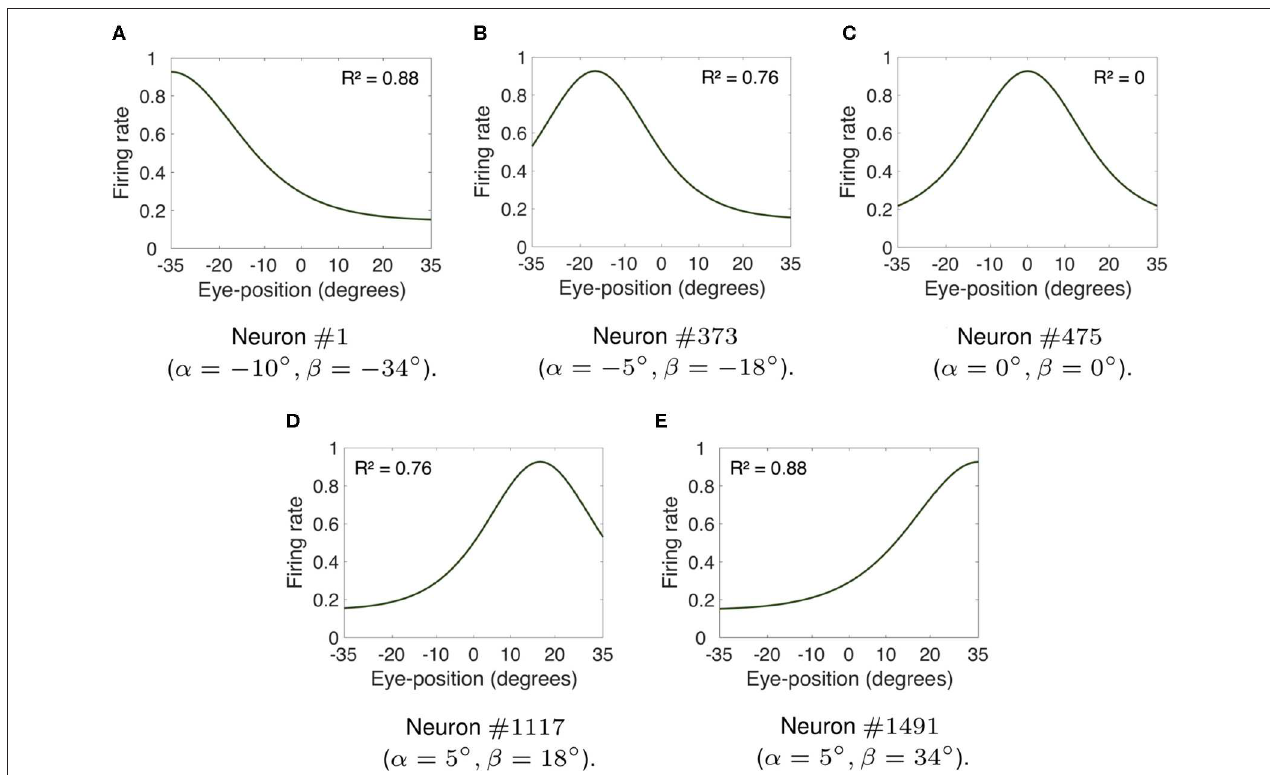
FIGURE 2 | Firing rate responses of visual neurons in the hardwired model. (A–E) show, respectively, the responses of neurons # 1, # 373, # 475, # 1,117, and # 1,491 when the visual target was kept at each neuron’s preferred retinal location whilst the eyes shifted in integer steps of one degree to all positions within [ − 35,35 ◦ ]. The preferred retinal location of each of these neurons was set to − 10, − 5, 0, 5, and 10 ◦ . The preferred eye position of each neuron was − 34, − 18, 0, 18, and 34 ◦ , respectively. The coefficient of determination R 2 provides a measure of linearity of the visual responses of each visual neuron. The values of R 2 are defined within [0,1], where 1 implies a perfect linear fit. In particular, whilst (C) shows that the response profile of neuron # 475 was not linear (i.e., R 2 = 0), all other subplots had more linear responses (i.e., values of R 2 closer to 1). (A,E) had approximately linear monotonic response profiles covering the whole eye position space. Table 1 shows the simulation parameters for the model. These simulation results show that modeling the input components representing both the position of the eye and the retinal location of the visual stimulus using biologically realistic Gaussian functions results in a variety of forms of visual responses similar to parietal responses, including peaked and